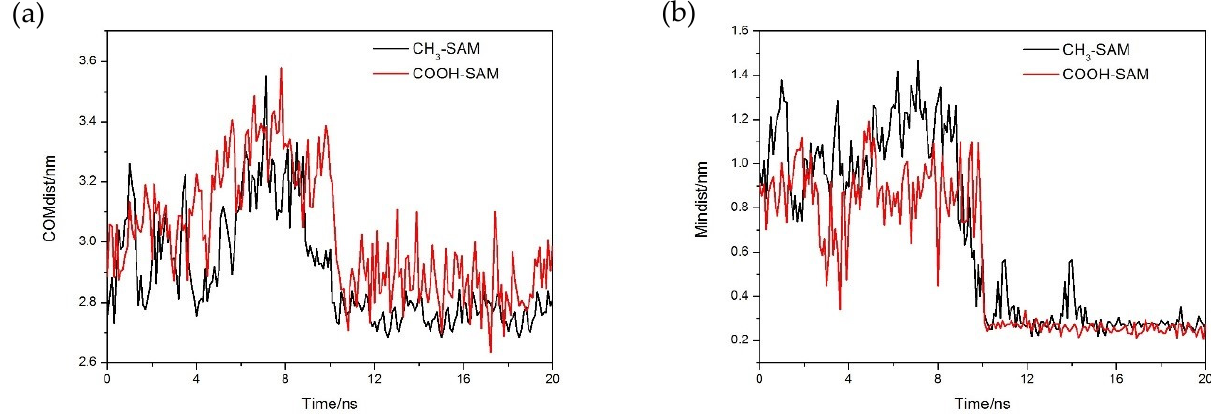
Figure 2. ( a ) The variation of the distance between mussel protein core and antifouling membrane with time; ( b ) the variation of the minimum distance between mussel protein and antifouling membrane with time.